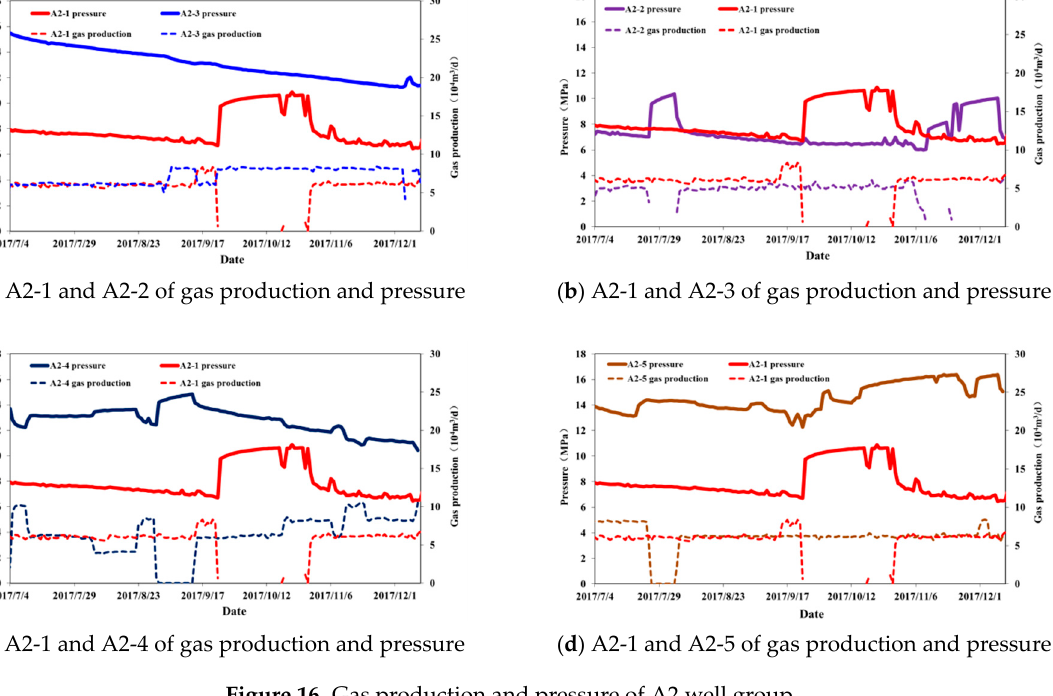
Figure 16. Gas production and pressure of A2 well group.